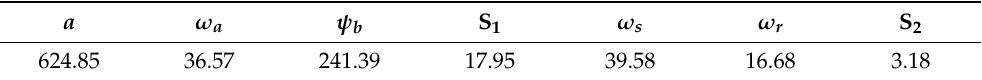
Table 2. Soil–water characteristic curve eigenvalues of modified